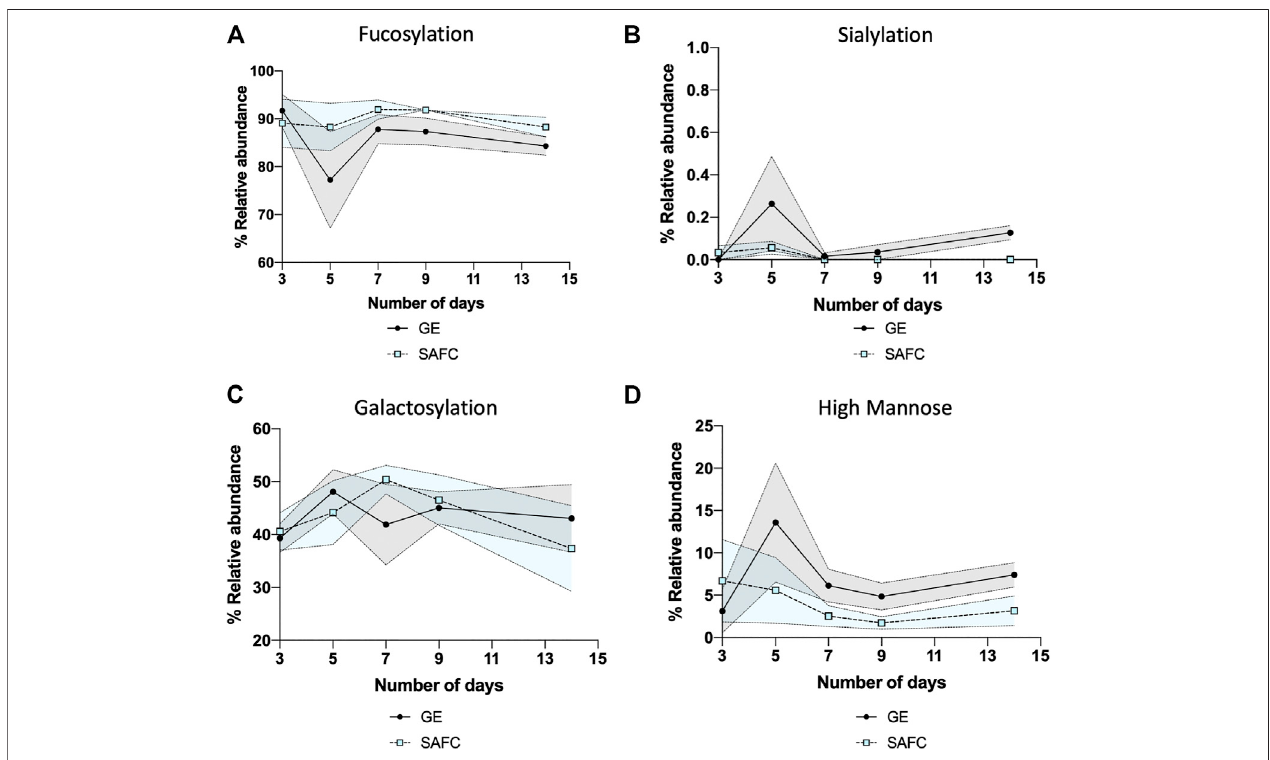
FIGURE 8 | The relative abundance of (A) fucosylation, (B) sialylation, (C) galactosylation, and (D) high mannose structure of in-house produced trastuzumab biosimilar cultured in GE or SAFC media and on different length of duration. (Two-way ANOVA followed by Bonferroni ’ s post hoc test, multiple comparisons were performed between GE and SAFC media, n (cid:2) 3; shaded area denotes ± 1 standard